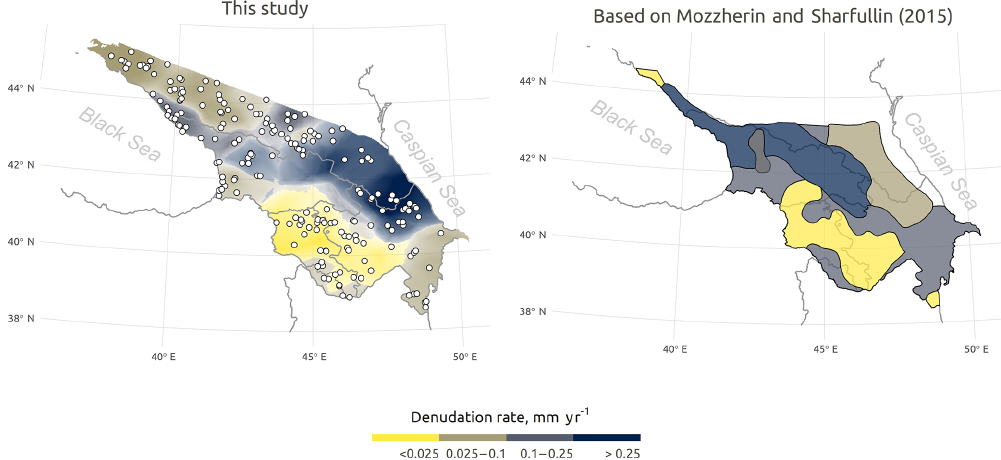
Figure 4. Spatial patterns of estimated average denudation rates for the Caucasus (mmyr − 1 ) and comparison with the estimates of Mozzherin and Sharifullin